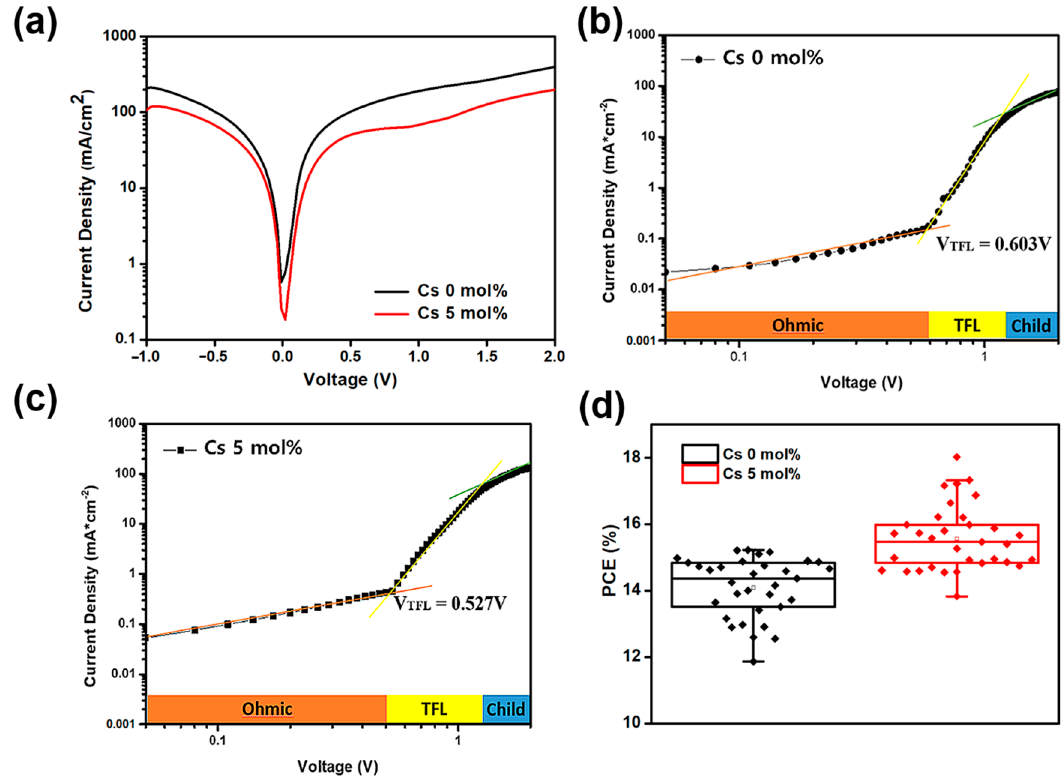
Figure 4. ( a ) Dark J − V characteristics of the PSCs with and without 5 mol% cesium doping. SCLC of the PSCs ( b ) without and ( c ) with cesium doping. ( d ) PCE distribution box chart of the PSCs without and with 5% cesium doping.